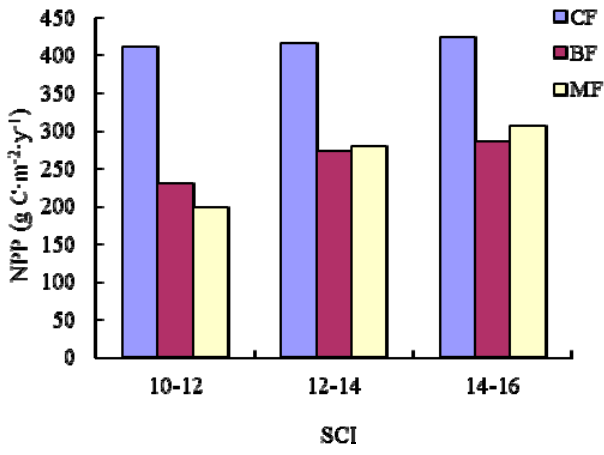
Figure 9. Average NPP for each SCI value for the three main forest type groups in Heilongjiang province, China, from 2001 to 2010.